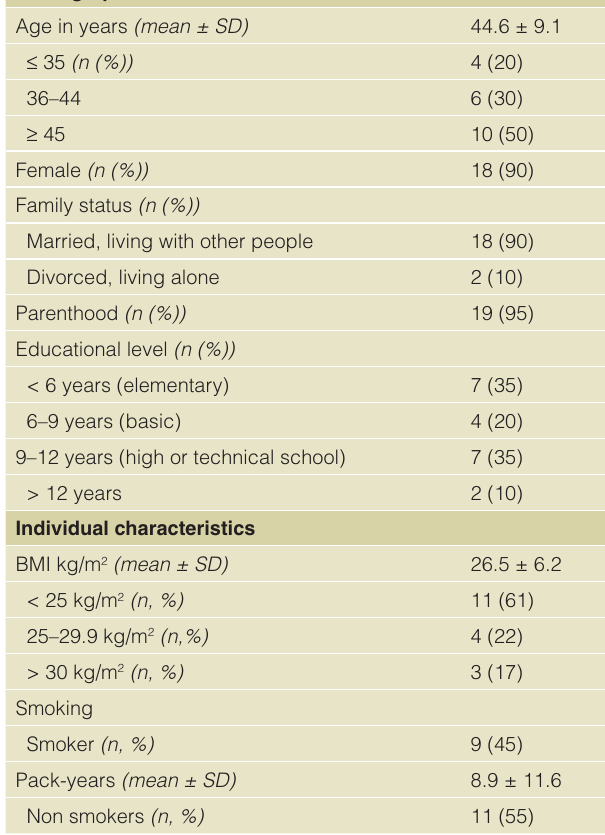
Table 2. Demographic and individual characteristics of the intervention group